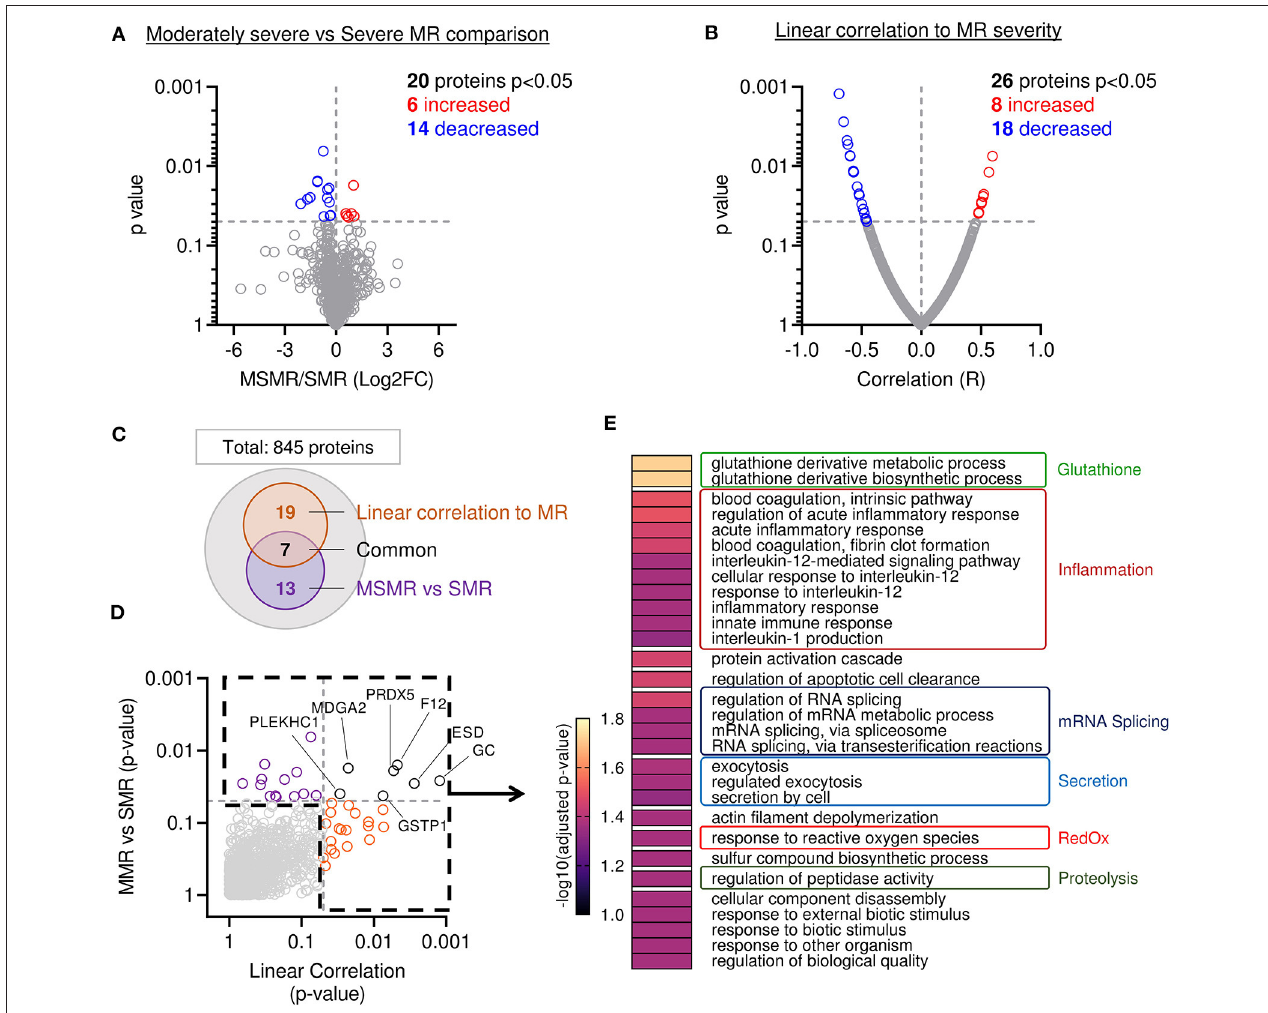
FIGURE 3 | Mitral leaflets from patients with higher MR display proteomic change associated to proteolysis-, inflammatory-, and oxidative stress-related processes. (A) Comparison of proteome composition from the samples having moderately severe MR (MSMR n = 1) vs. the samples with severe MR (SMR n = 6) Volcano plot displaying the log2 fold-change (x-axis) against the statistical p -value (log scale) for all 845 proteins detected. Proteins with significantly increased expression (Log2FC > 0, p < 0.05) in SMR group are shown in red, while the proteins with significantly decreased expression (Log2FC > 0, p < 0.05) are expressed in blue. (B) Comparison of proteomic composition using linear correlation with MR level quantification (vena contracta). Dot plot displaying the R (x-axis) against the statistical p -value (log scale) for all 845 patients detected. Proteins with the significant and positive correlation (R > 0, p < 0.05) to MR are shown in red, while the proteins with significant and negative correlation (R < 0, p < 0.05) are presented in blue. (C) Venn diagram displaying modulated proteins obtain from the linear correlation to MR (orange) and MSMR vs. SMR comparison (purple), common proteins were identified in black. (D) Dot plot exhibiting p -value 845 patients identified from both analyses presented linear correlation to MR (orange), MSMR vs. MR comparison (purple), common proteins (black). (E) Heatmap of gene ontology biological process (GO:BP) enriched from protein significantly modulated.